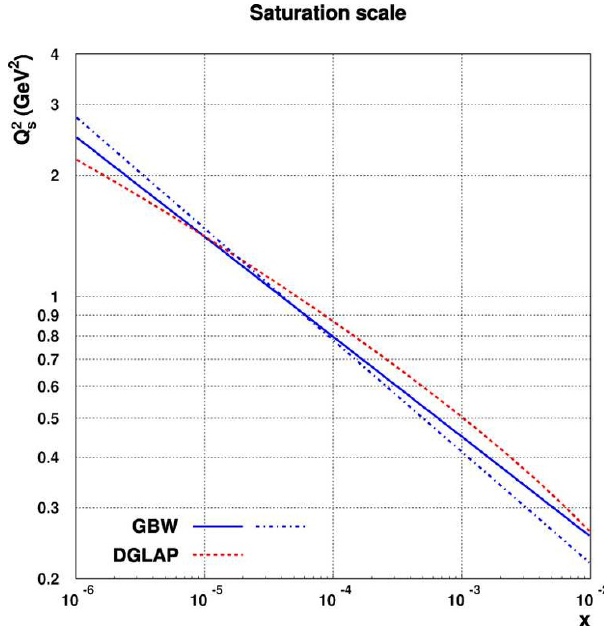
Figure 4 . The saturation scale in the GBW model (solid line), eq. (2.7), and DGLAP improved model (dashed line), eq. (2.16), with the parameters from Fit 2 in table 1 and 3, respectively. The saturation scale from the original GBW model with charm [26] is shown as the dash-dotted